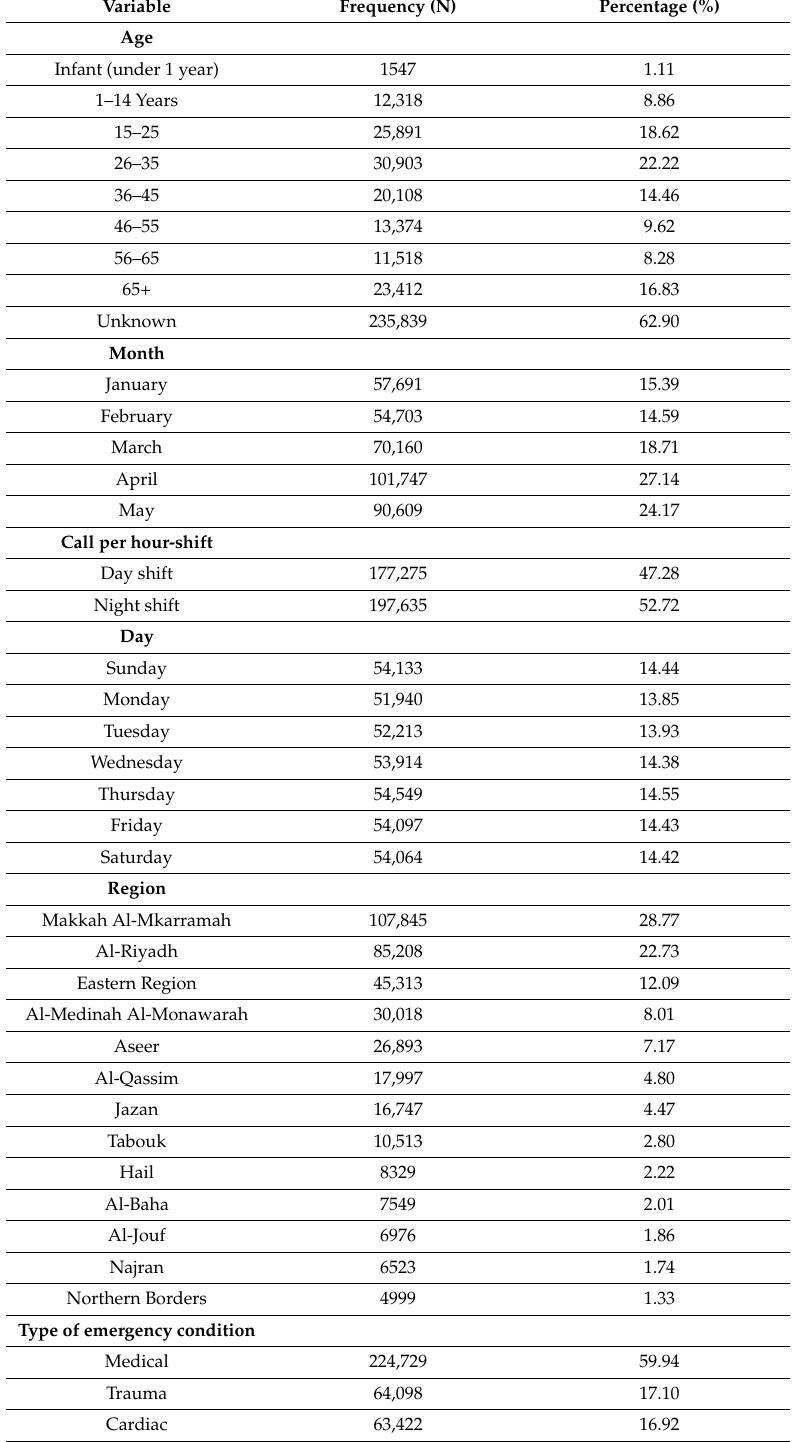
Table 1. Description of Saudi Red Crescent Authority (SRCA) emergency callers (n = 374,910)